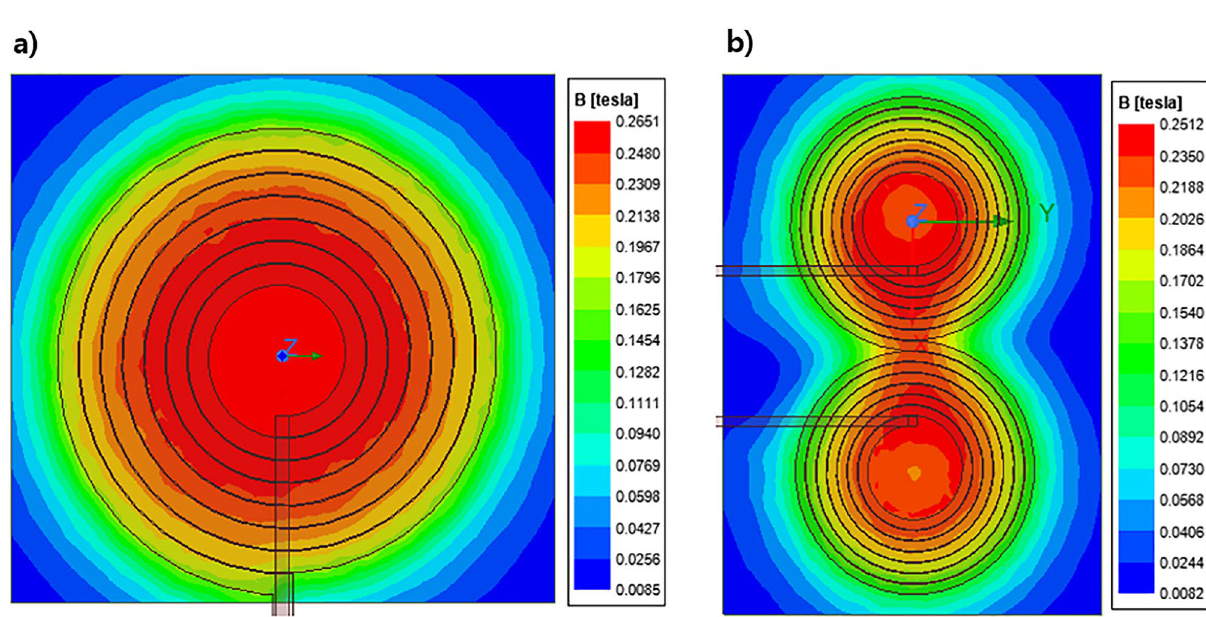
Figure 5. Comparison of magnetic field intensity on observation plane: ( a ) designed circular coil; ( b ) figure 8-shaped